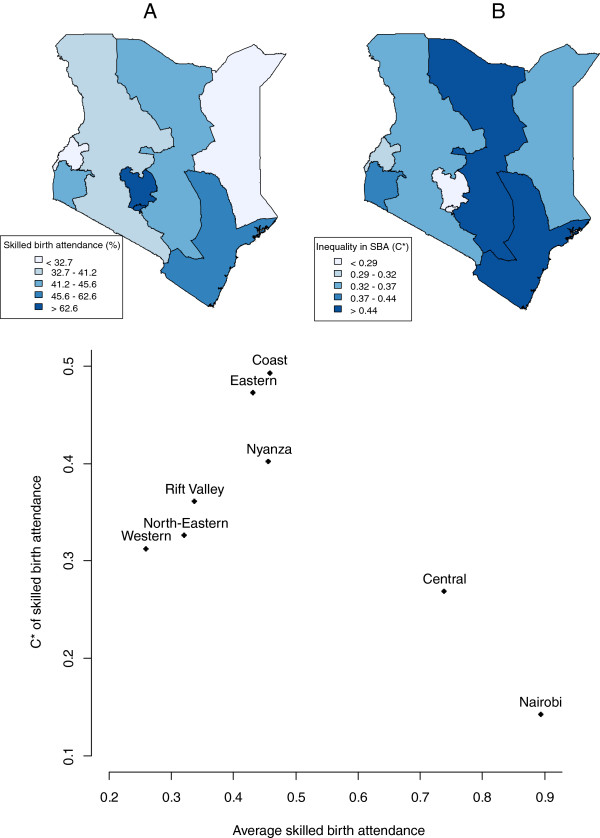
Regional distributions of average (A) and inequality in (B) skilled birth attendance, Kenya, DHS 2008/09. * = Erreygers’ corrected concentration index [24].